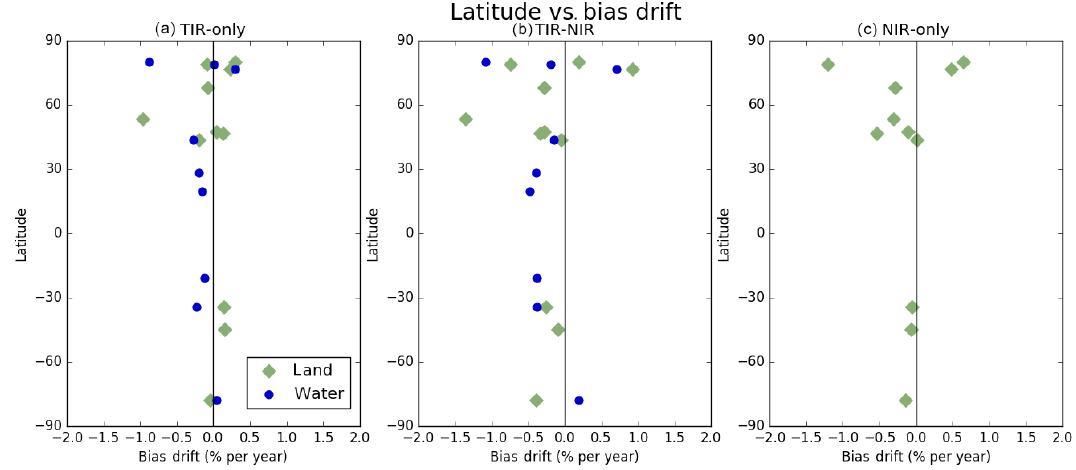
Figure 9. Geographic variability in bias drift. Columns are for the different MOPITT data products – (a) TIR-only, (b) TIR–NIR, and (c)